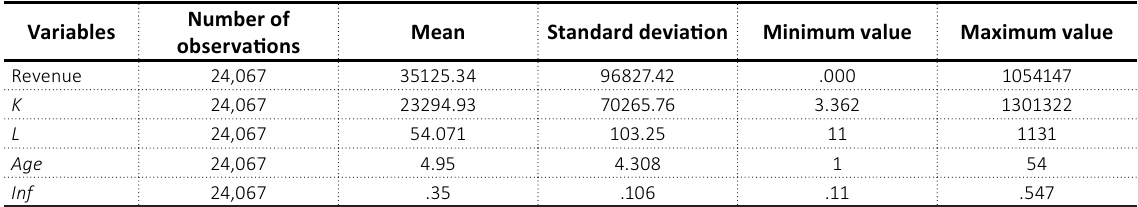
Table A2. Estimation result of model (2) with D